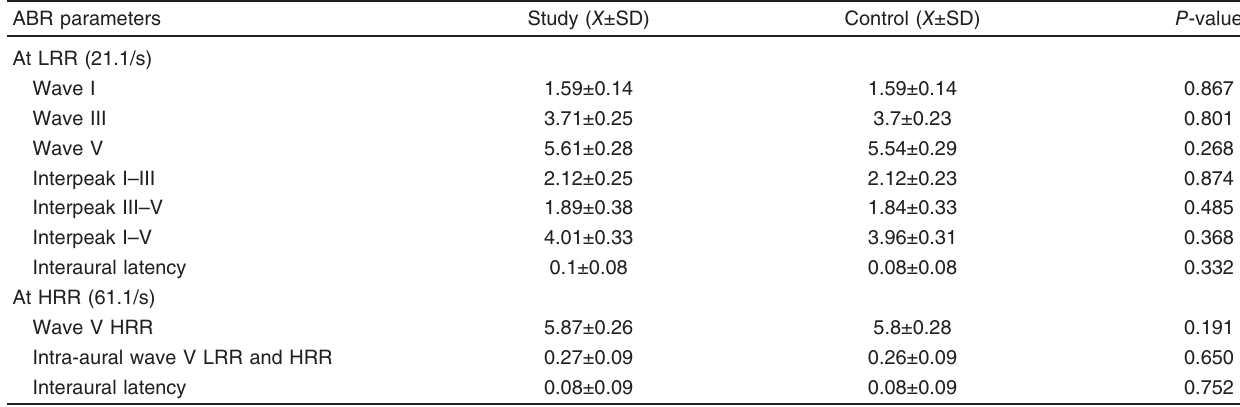
Table 7 Results of different auditory brainstem response parameters at both low repetition rate (21.1/s) and high repetition rate (61.1/s) for both the study and the control group